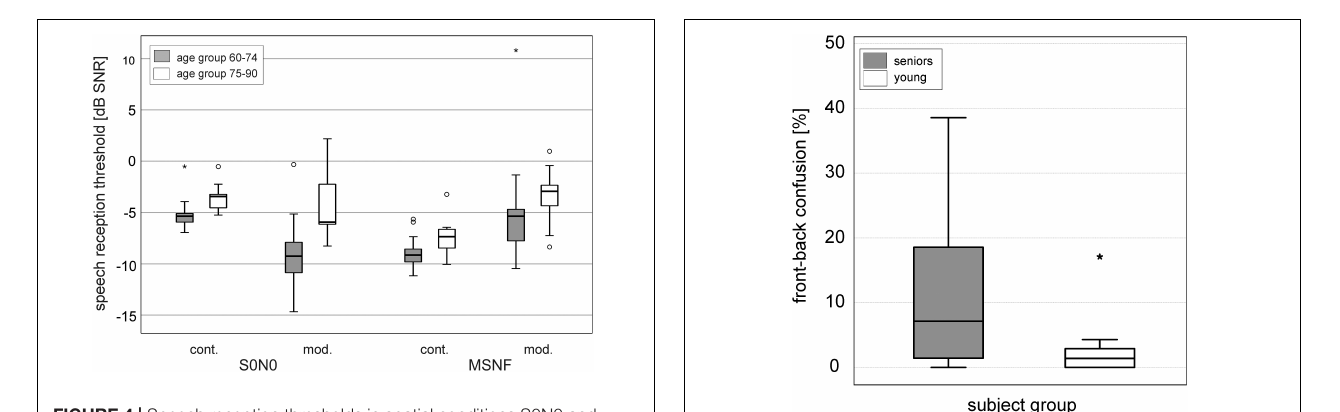
FIGURE 4 | Speech reception thresholds in spatial conditions S0N0 and multi-source noise field (MSNF) for the continuous (cont.) noise and modulated (mod.) noise divided into age groups 60–74 years (gray boxes) and 75–90 years (white boxes). * Outliers 3 times greater than interquartile range.